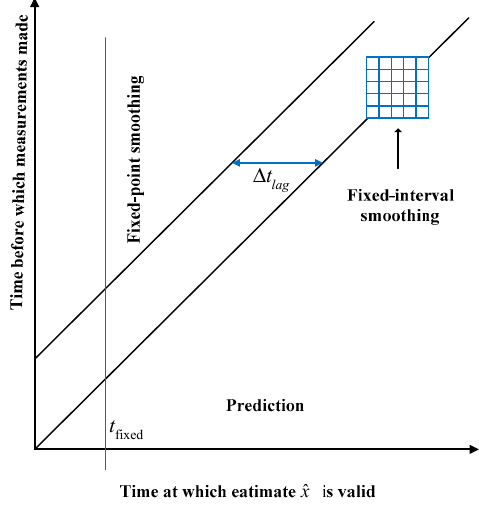
Figure 3. Estimate / measurement timing constraints Figure 3. Estimate/measurement timing constraints [55] .